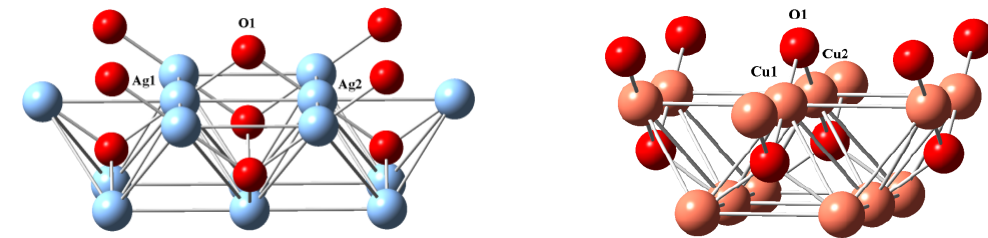
Figure 2. Cluster surface (001) of catalysts, using experimental lattice parameters a = 4.7230 Å (Ag 14 O 9 ) and 4.2696 Å (Cu 14 O 9 ). Color codes: O (red), Ag (light blue), and Cu (coppery). Two oxygen atoms symmetrically located at the upper corners were deleted in the simulation.